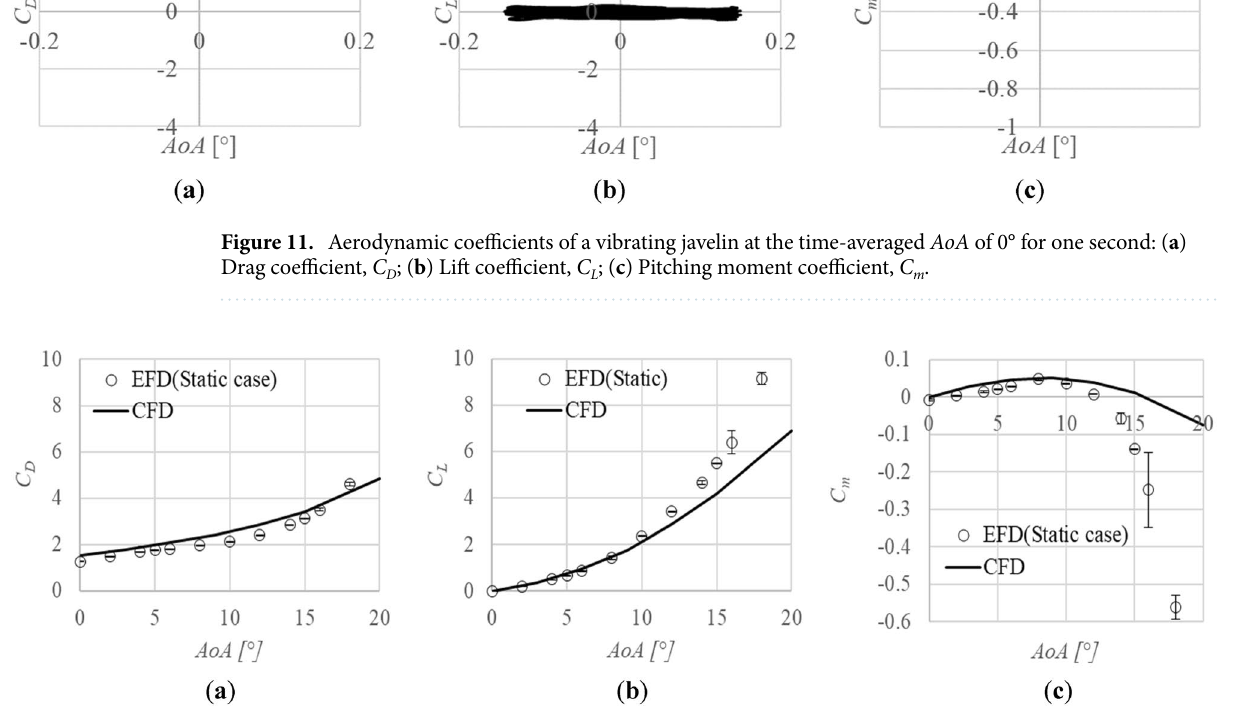
Figure 12. EFD (Experimental Fluid dynamics) results by MSBS are shown by open circles, while the CFD results are shown by the solid line as a function of the angle of attack, AoA . The 95% confidence intervals are also shown as error bars: ( a ) Drag coefficient, C D ; ( b ) Drag coefficient, C L ; ( c ) Pitching moment coefficient, C m